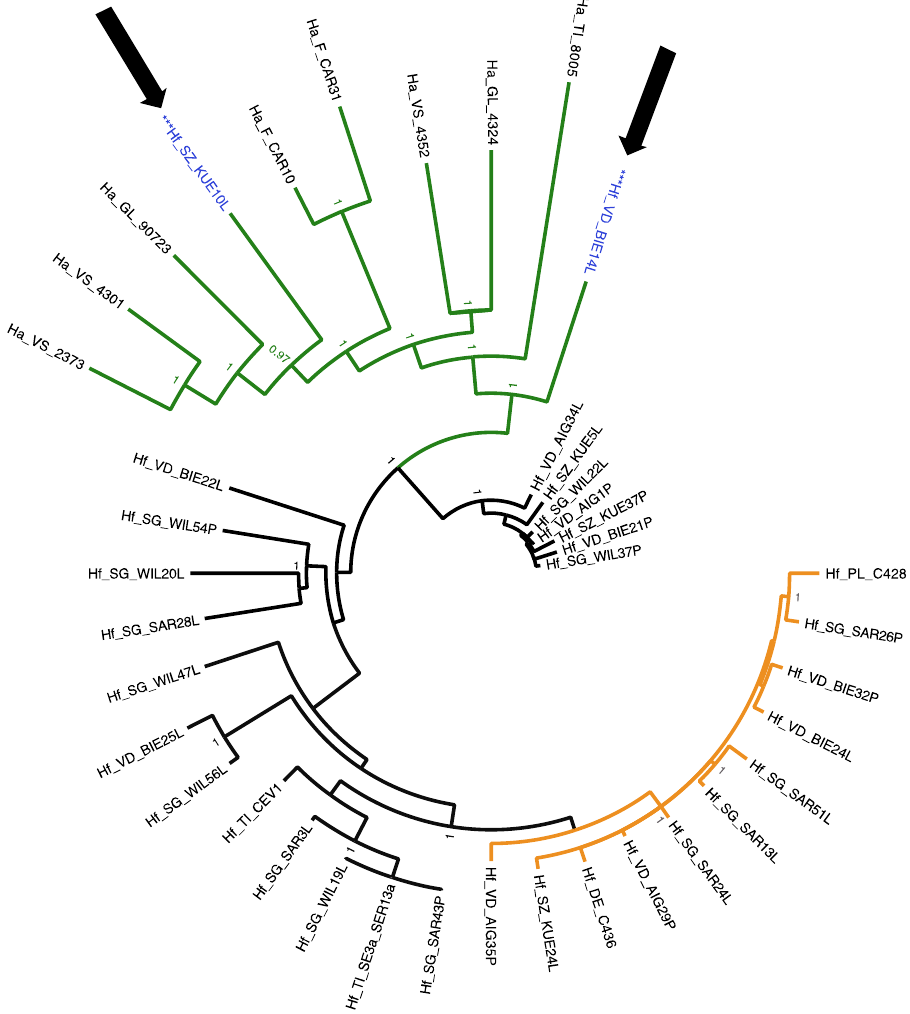
Figure 2. Phylogenetic tree resulting from the MrBayes analysis conducted with 40 (8 H. albidus , 32 H. fraxineus ) full sequences (2151 bp) of the RdRP gene of the mitovirus HfMV1. Green color depicts HfMV1 H. albidus group isolates. Black color depicts HfMV1 group 2 isolates and orange color HfMV1 group 1 isolates. Blue color and *** marks H. fraxineus isolates within the H. albidus group. Hf characterizes viral sequences from H. fraxineus , Ha from H. albidus isolates. For abbreviation see Table 1. Posterior probabilities are shown at the respective branch if they were >0.95. Arrows indicate intermixing of H. albidus and H. fraxineus HfMV1 sequences.